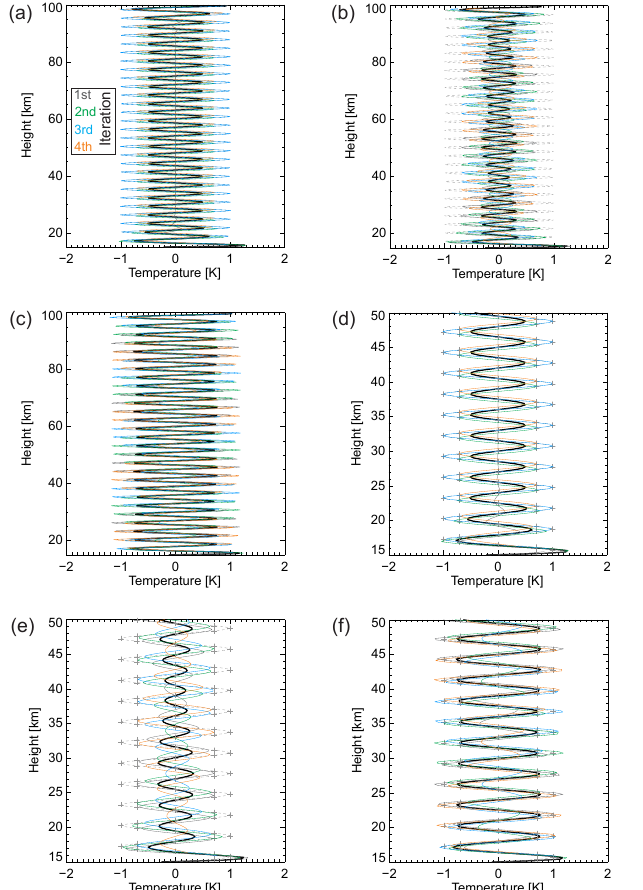
Figure 5. Here, the results based on the repeating spline approach are shown. The different colours refer to the different spline ap- proximations (to keep it as clear as possible, we only show the first four iterations, a fifth one exists for case (b) and (e) ; see step 4 of the algorithm). The black line represents the final spline approxima- tion. The distance between two spline sampling points in parts (a) to (f) agrees with the respective values in Fig. 2 parts (a) to (f) . While parts (a) to (c) show the height range between 15 and 100km, parts (d) to (f) focus on the height range between 15 to 50km. The asterisks have the same meaning as in Fig. 2.